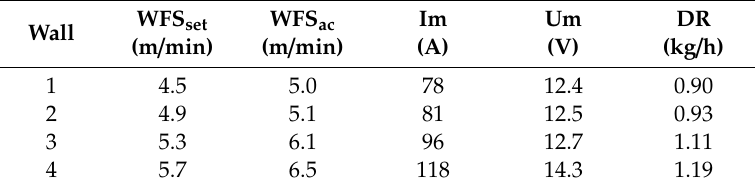
Table 2. Determination of the deposition rates (DR) and actual wire feed speeds WFS ac (CTWD = 15 mm and TS = 42 cm / min).